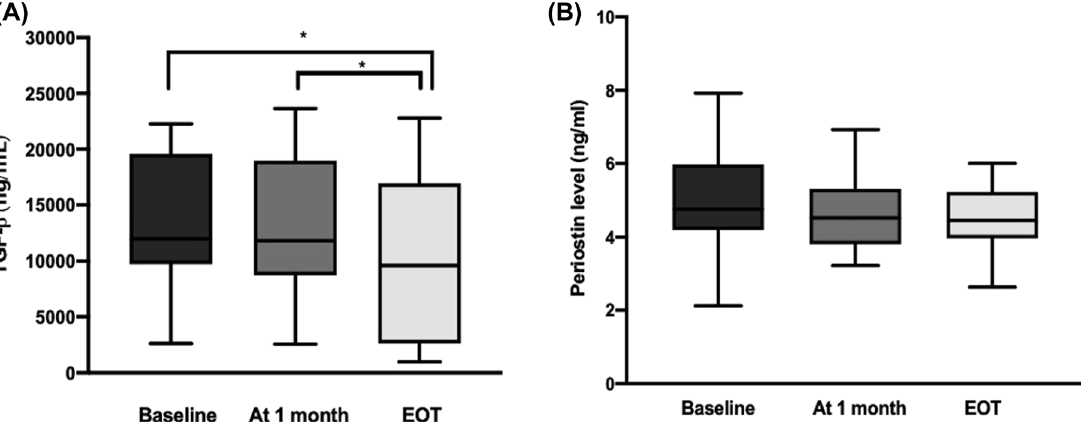
Figure 2: Comparison of (A) the serum TGF- β levels and (B) serum periostin levels in CHC cases at different time points. *p<0.001. Data are presented with the Tukey box-and-whisker plot, where the middle line represents the median, and the box represents the IQR (the 25th and 75th percentiles). TGF- β , transforming growth factor-beta; CHC, chronic hepatitis